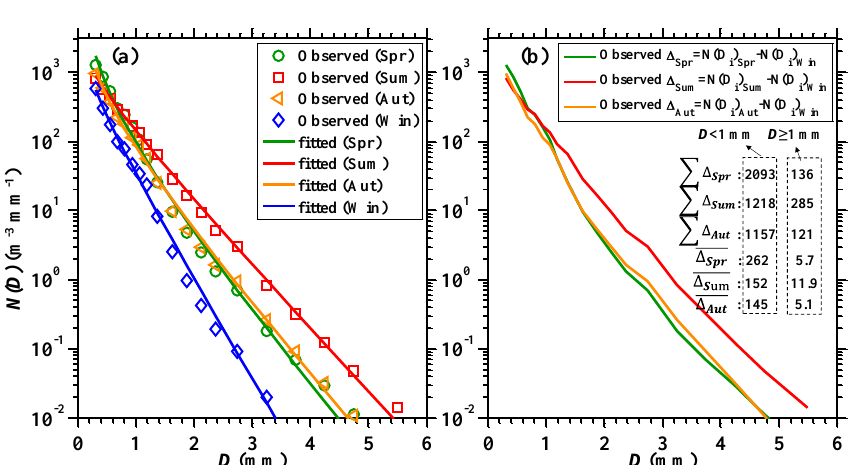
Figure 2. Composite raindrop spectra (markers) and corresponding fitted curves by normalized Gamma model ( a ) for four seasons during the observation period and deviations of number concentrations between spring and winter, summer and winter, and autumn and winter ( b ). In subgraph ( b ), deviations ( ∆ Spr , ∆ Sum , and ∆ Aut ) were calculated by subtracting the number concentrations of spring, summer, and autumn from that of winter, respectively. The sum and average of deviations for small raindrops ( D < 1 mm) and medium-to-large raindrops ( D ≥ 1 mm) are also listed in the subgraph.